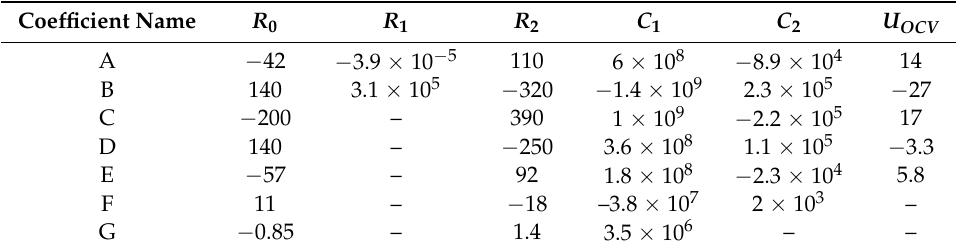
Table 1. Values of polynomial coefficients from dependency (9) for DP